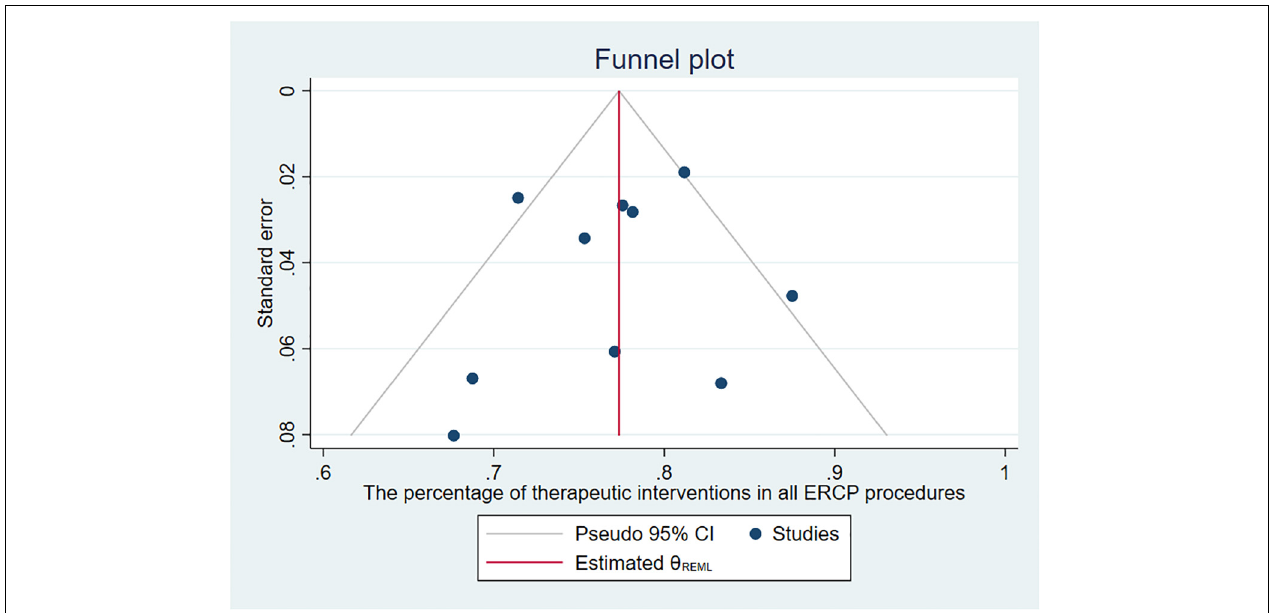
FIGURE 3 | Funnel plot of the percentage of therapeutic interventions in all ERCP